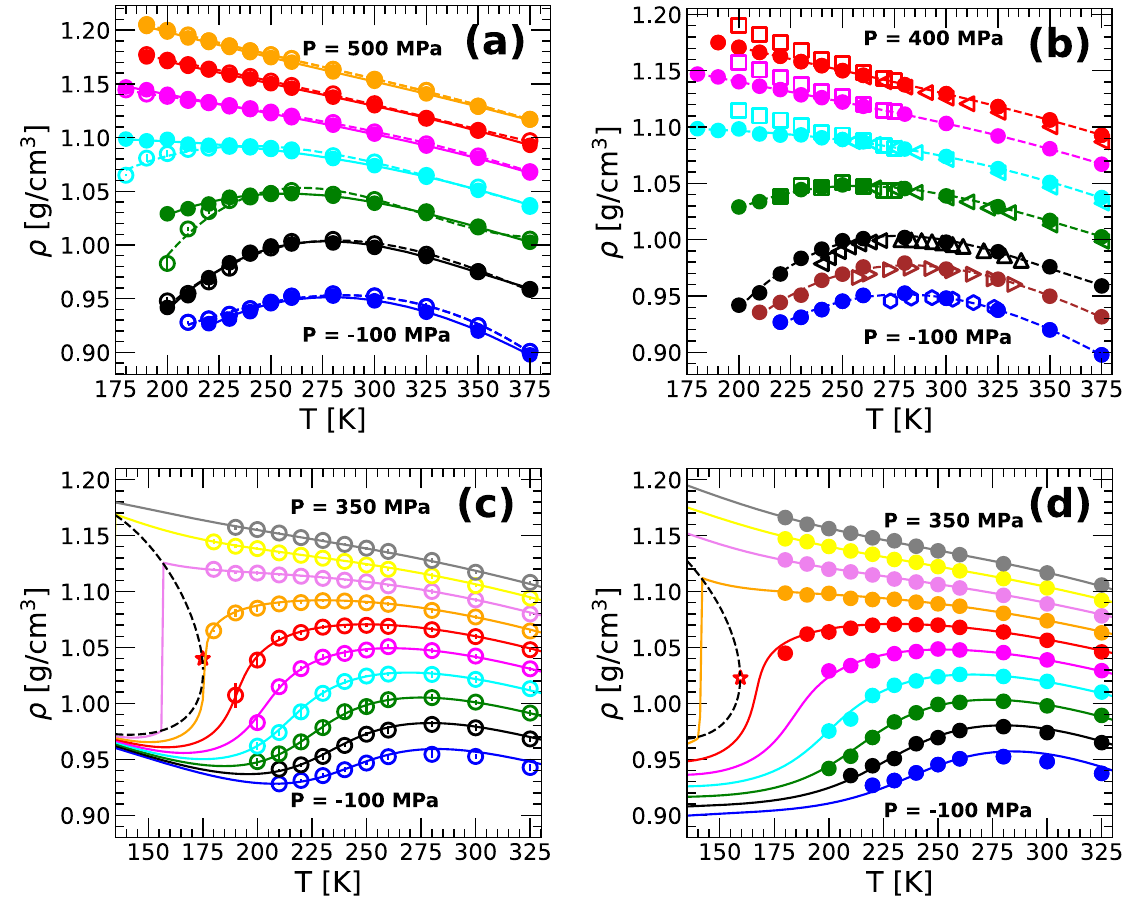
Figure 1. Density of q-TIP4P/F water as function of temperature along selected isobars. ( a ) Comparison of ρ( T ) from classical MD (open circles) and PIMD simulations (solid circles). Pressures are (bottom to top) P = − 100, 0.1, 100, 200, 300, 400, 500 MPa. ( b ) Density of q-TIP4P/F water from PIMD simulations (solid circles) and experiments (open symbols; squares, left-triangles, up-triangles, right-triangles, and diamonds are, respectively, from Refs. 12,16,59–61 ). Pressures are (bottom to top) P = − 100, − 50, 0.1, 100, 200, 300, 400 MPa. Deviations between experiments and simulations are noticeable only at high pressures, P > 200 MPa, and low temperatures, T < 240 K. ( c ) Fit of the q-TIP4P/F water densities shown in ( a ) using the TSEOS (solid lines). ( d ) Fit of the q-TIP4P/F water densities shown in ( b ) using the TSEOS (solid lines). Pressures in ( c ) and ( d ) are (bottom to top) P = − 100, − 50, 0.1, 50, 100, 150, 200, 250, 300, 350 MPa. The liquid–liquid binodal line and LLCP predicted from the TSEOS are denoted by the black dashed line and red